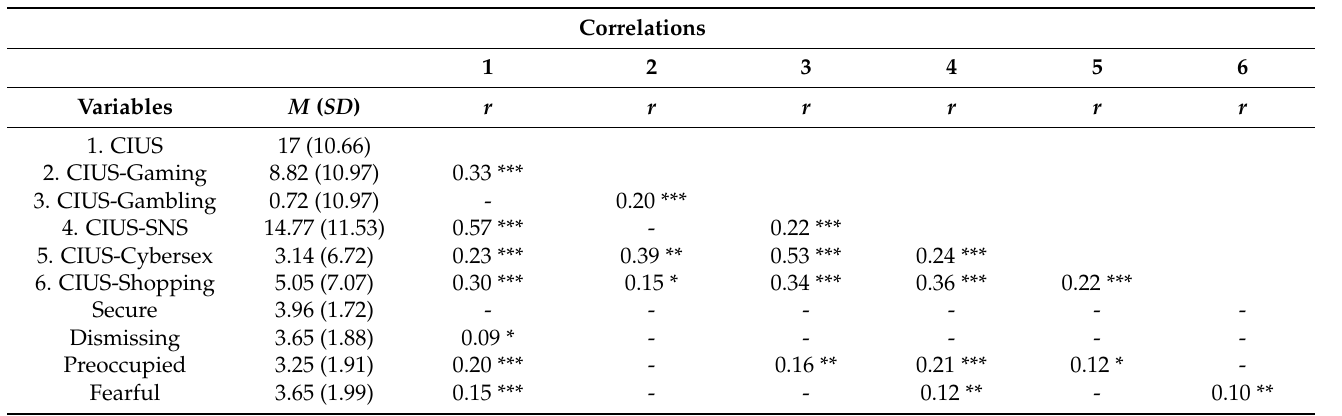
Table 3. Relationship between compulsive internet use scales (CIUS) and attachment styles measured by the Relationships Questionnaire (RQ) Test.